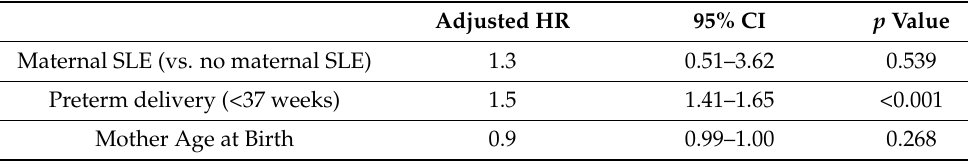
Table 5. Long-term neurological morbidity of children to women with SLE assessed by Cox proportional hazards model.